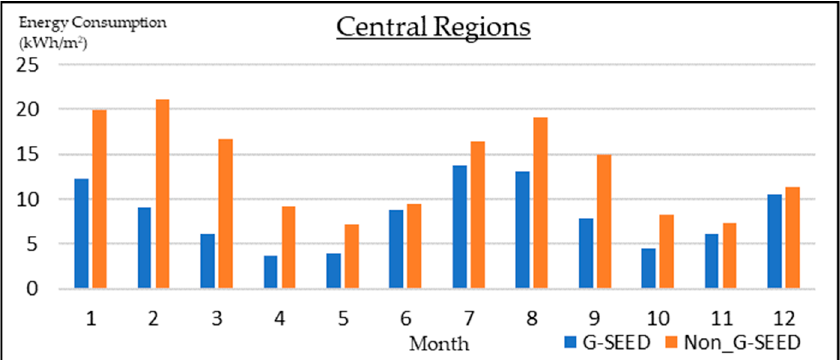
Figure 6. Bar chart of the monthly energy consumption of the courthouse buildings in the central region based on G-SEED certification.